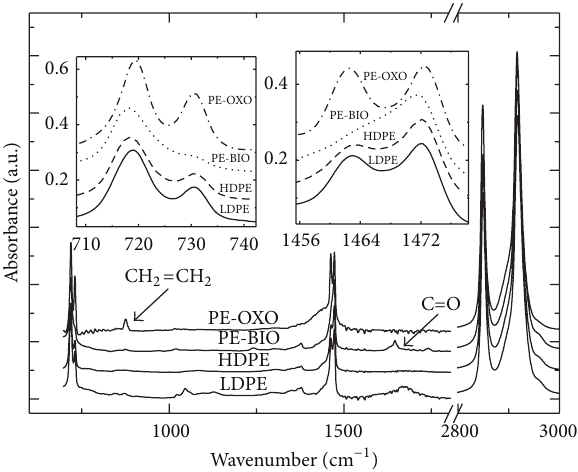
Figure 1: IR spectrum of the LDPE, HDPE, PE-BIO, and PE-OXO films without exposure to UV-B radiation.